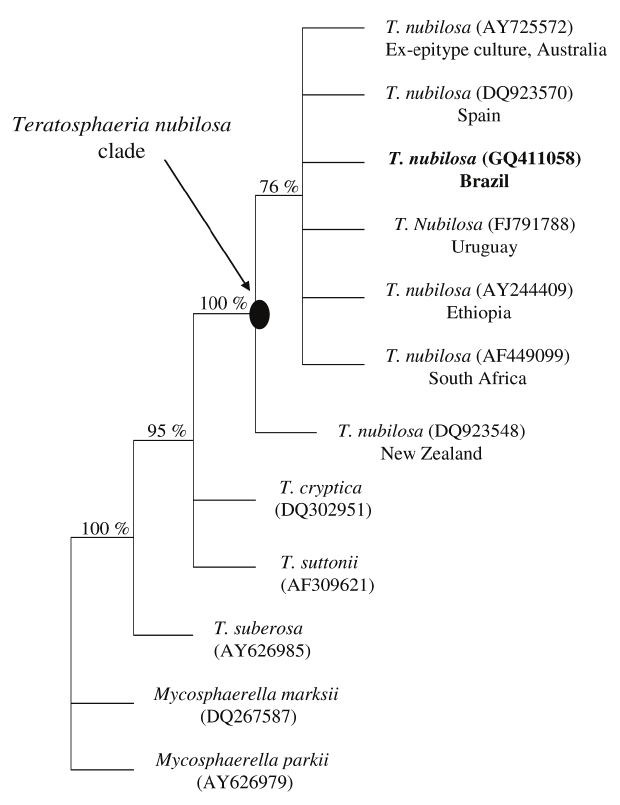
Fig. 3. Consensus phylogram obtained from the ITS sequence data using parsimony and heuristic search (Tree length =159, CI=0.7547, HI=0.2453, RI=0.7547). Bootstrap support values after 1000 randomizations are shown on the branching points. The arrow indicates the node defining the T. nubilosa clade. GenBank accession numbers are provided in brackets and the origin of the sequences behind each